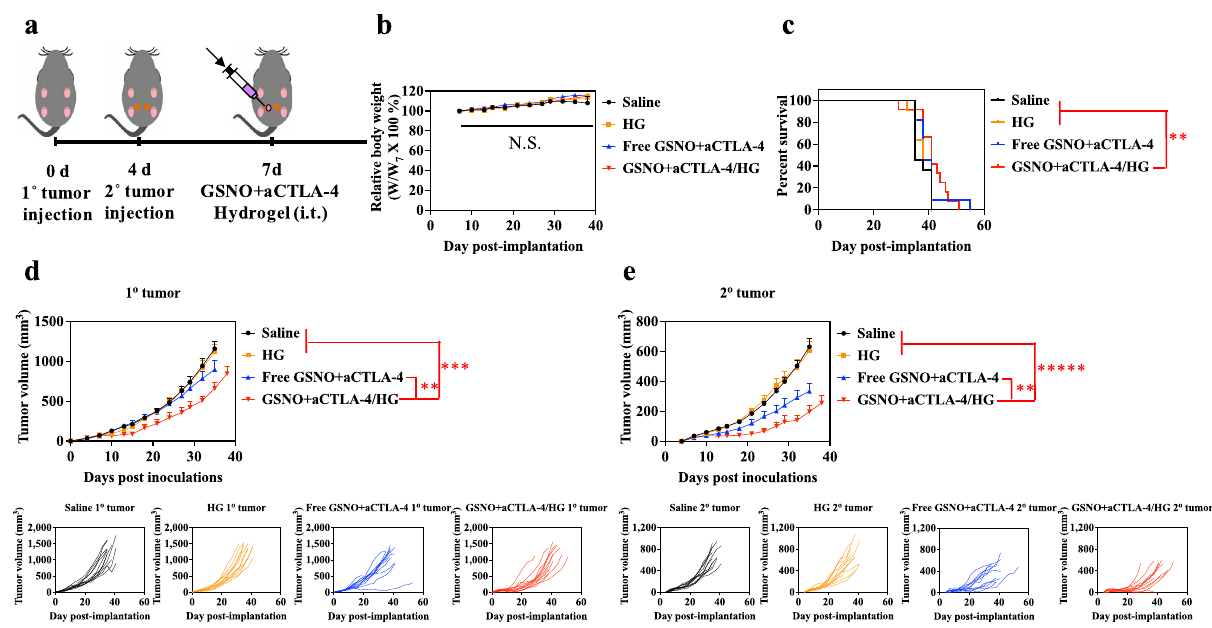
Fig. 7 Antitumor effects of GSNO and aCTLA-4 loaded F127- g -Gelatin hydrogel on 4T1 tumor models. a Tumor model and treatment schedule. 1 o and 2 o tumors were formed in Balb/C mice by inoculation of 3×10 5 4T1 cells in 30 μ L saline to left mammary fat pad on day 0 and at right mammary fat pad on day 4, respectively. GSNO (570 μ gkg − 1 ) and aCTLA-4 (50 μ g mouse − 1 ) were administered intratumorally on day 7 in a total volume of 30 μ L in saline or 4.5 wt.% F127- g -Gelatin hydrogel. b Relative body weight changes post treatment. c Kaplan – Meier survival curves. d 1 o (directly injected) tumor size. e 2 o (uninjected) tumor size. Data are presented as individual biological replicates and mean±SEM. n = 11 for saline, HG, and Free GSNO + aCTLA-4. n = 12 for GSNO + aCTLA-4/HG. *****p <0.0001, ****p <0.001, ***p <0.01, **p <0.05, and *p <0.1. Exact p -values for c – e are reported in Supplementary Tables 11 and 12. b Two-way ANOVA using Tukey post-hoc statistical hypothesis. c Log-rank using Mantel – Cox statistical hypothesis. d , e ANOVA using linear mixed-effects model. Source data are available in a Source Data fi